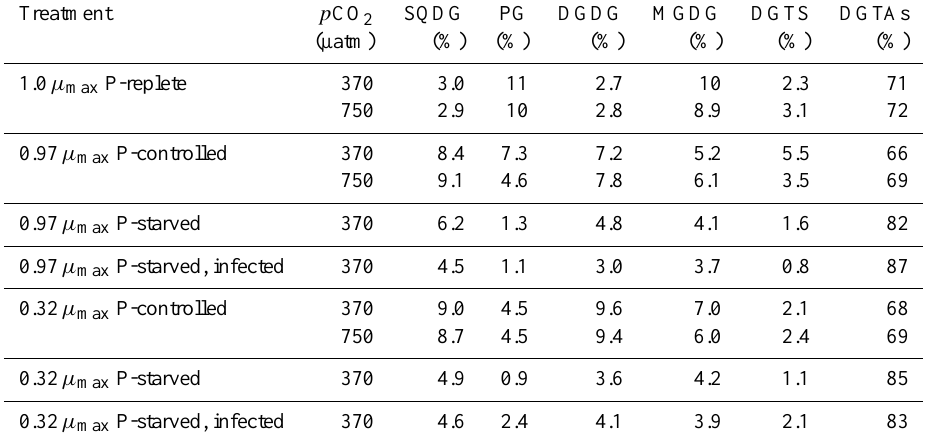
Table 2. Relative abundance of the IPL classes SQDGs, PGs, DGDGs, MGDGs, DGTSs and DGTAs in Micromonas pusilla LAC-38 as percentage of summed peak areas and per culturing treatment (horizontally sum 100%). Treatments consisted of P-replete growth and four different strengths of P limitation, i.e., P-controlled exponential chemostat growth at 0.97 and 0.32 µ max and 30h P starvation of both P- controlled treatments. The P-starved cultures were additionally infected with the virus MpV-08T, whereby the cells were still intact after 30h P starvation and infection. The P-replete and P-controlled cultures were subjected to 370 and 750µatm CO 2 . Treatment p CO 2 SQDG PG